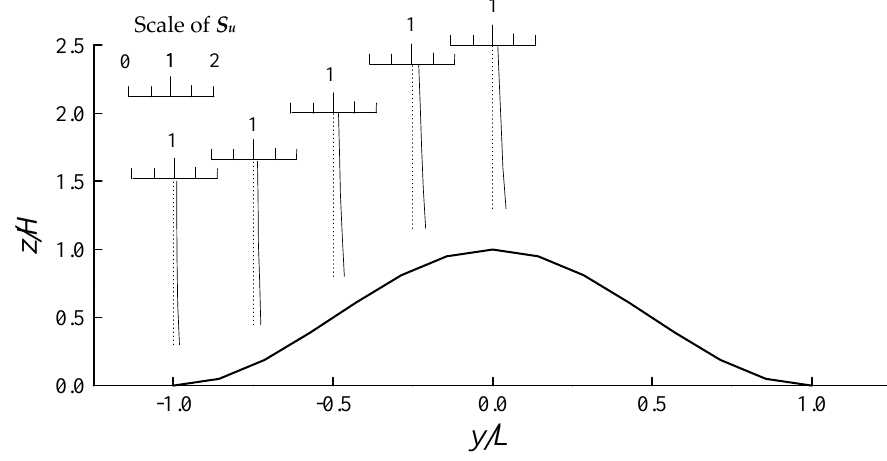
Figure 7. The streamwise mean wind speed ‐ up S u on the crosswind center line of the hill ( x = 0).